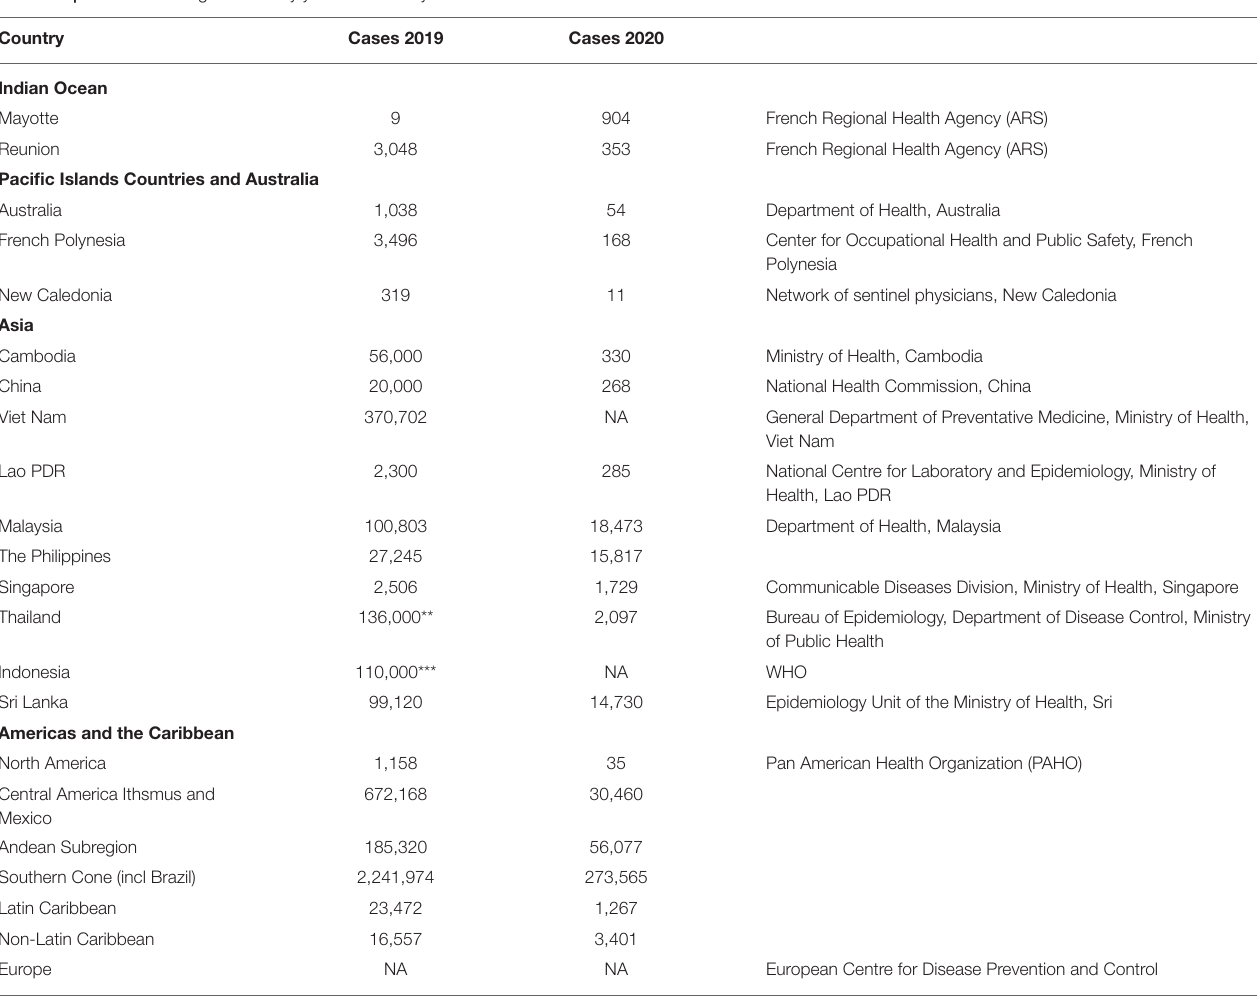
TABLE 1 | List of total dengue cases by year and country.